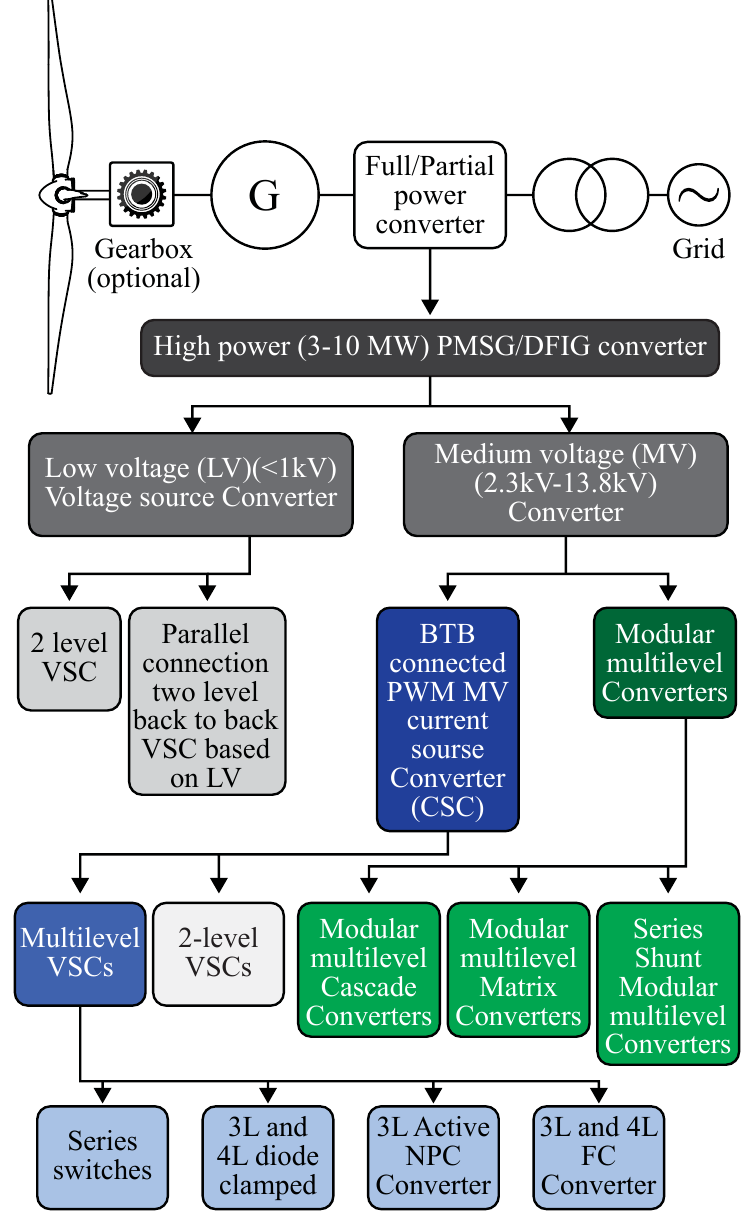
Figure 5. Power converters for PMSG and